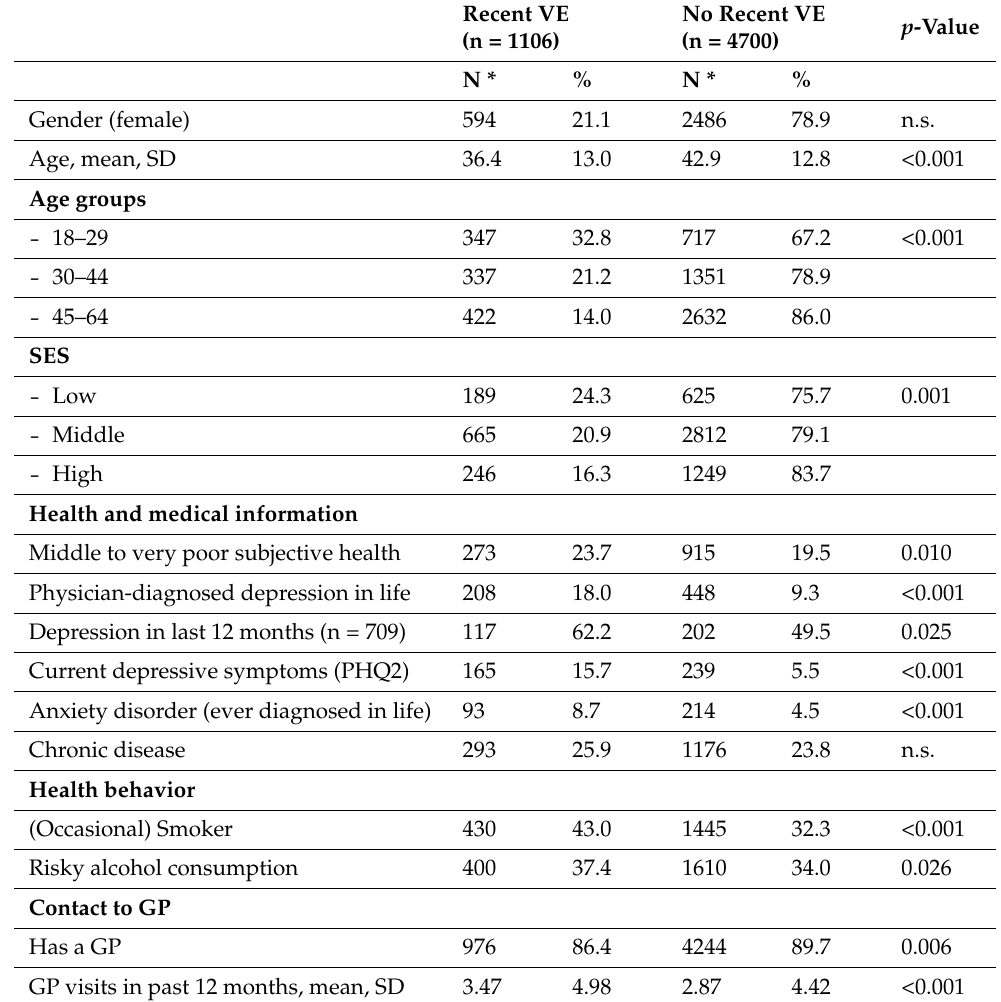
Table 2. DEGS1: Comparison of socio-demographic characteristics, health, and GP attendance of recent victims and non-victims (weighted